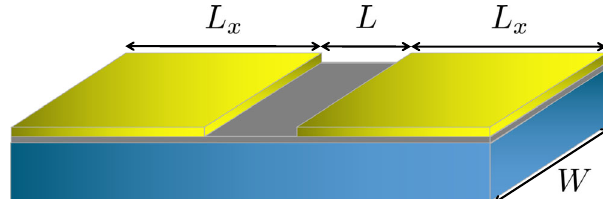
speed of light), the identity 1 σ and the set of Pauli matrices